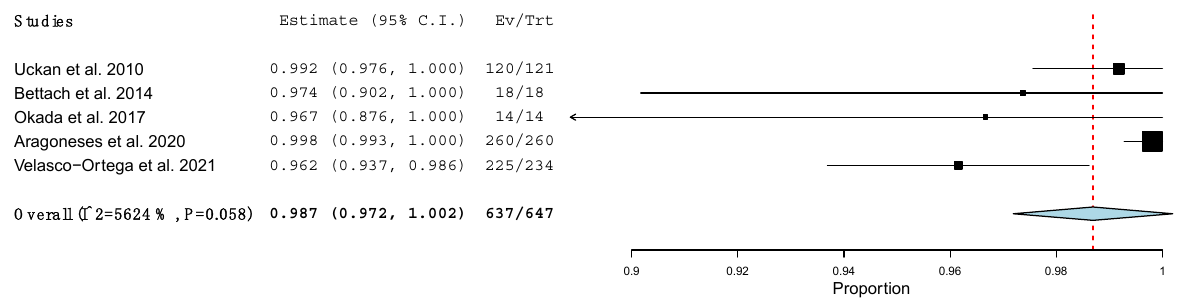
Figure 3. Forest plot of the implant survival rate independently of the surgical procedure.